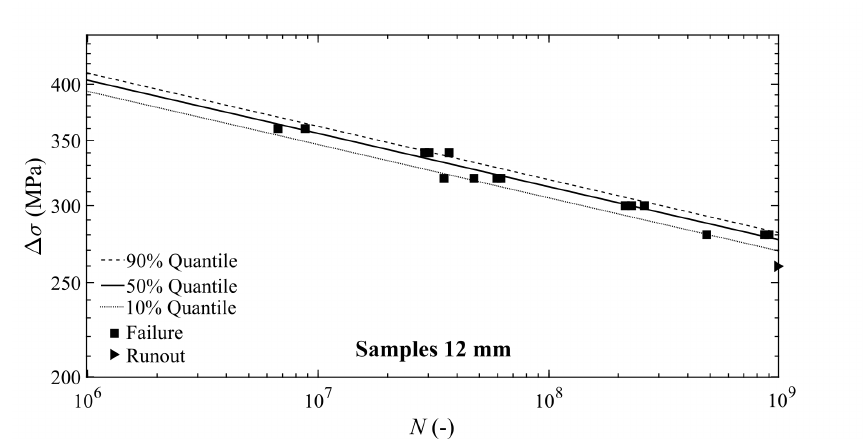
Figure 15. P-S-N curves for the specimens of 12 mm in